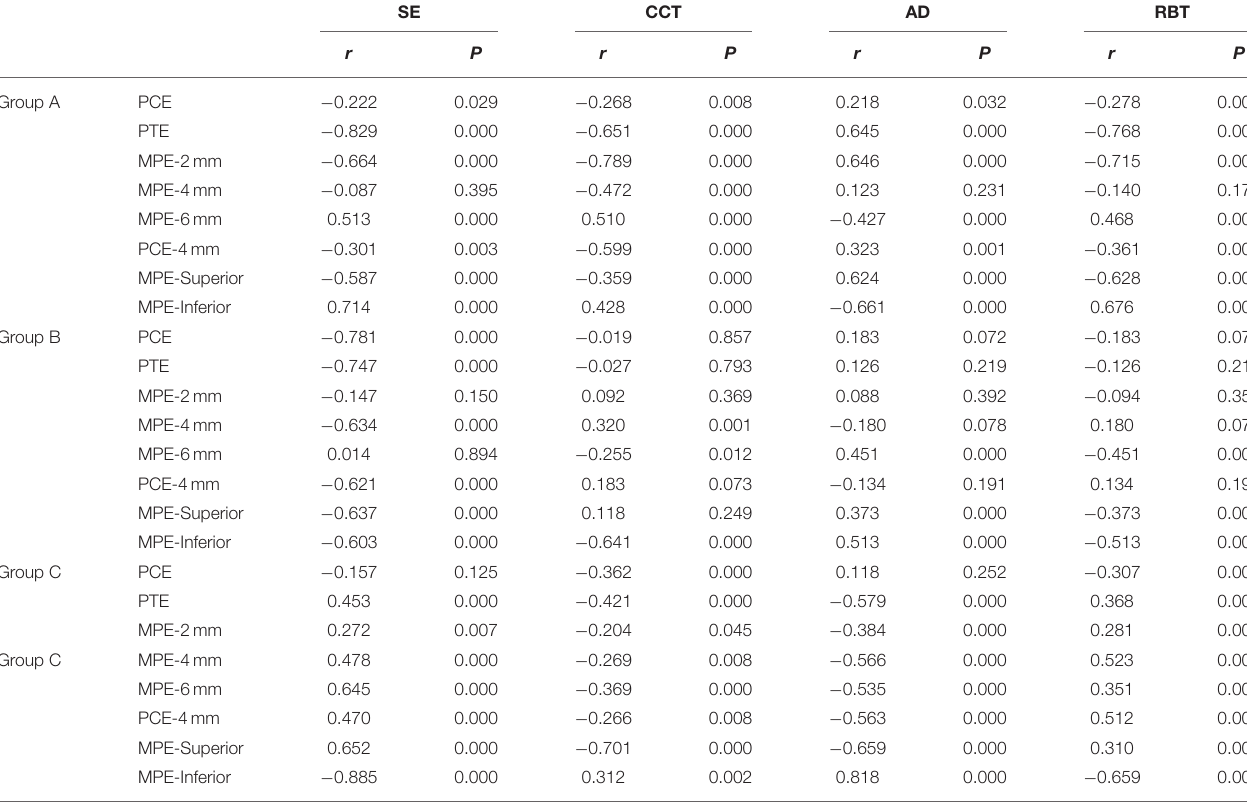
TABLE 4 | Statistical correlation between changes of posterior corneal elevation after 3 years of SMILE and preoperative spherical equivalent (SE), preoperative minimum central corneal thickness (CCT), ablation depth (AD), residual bed thickness